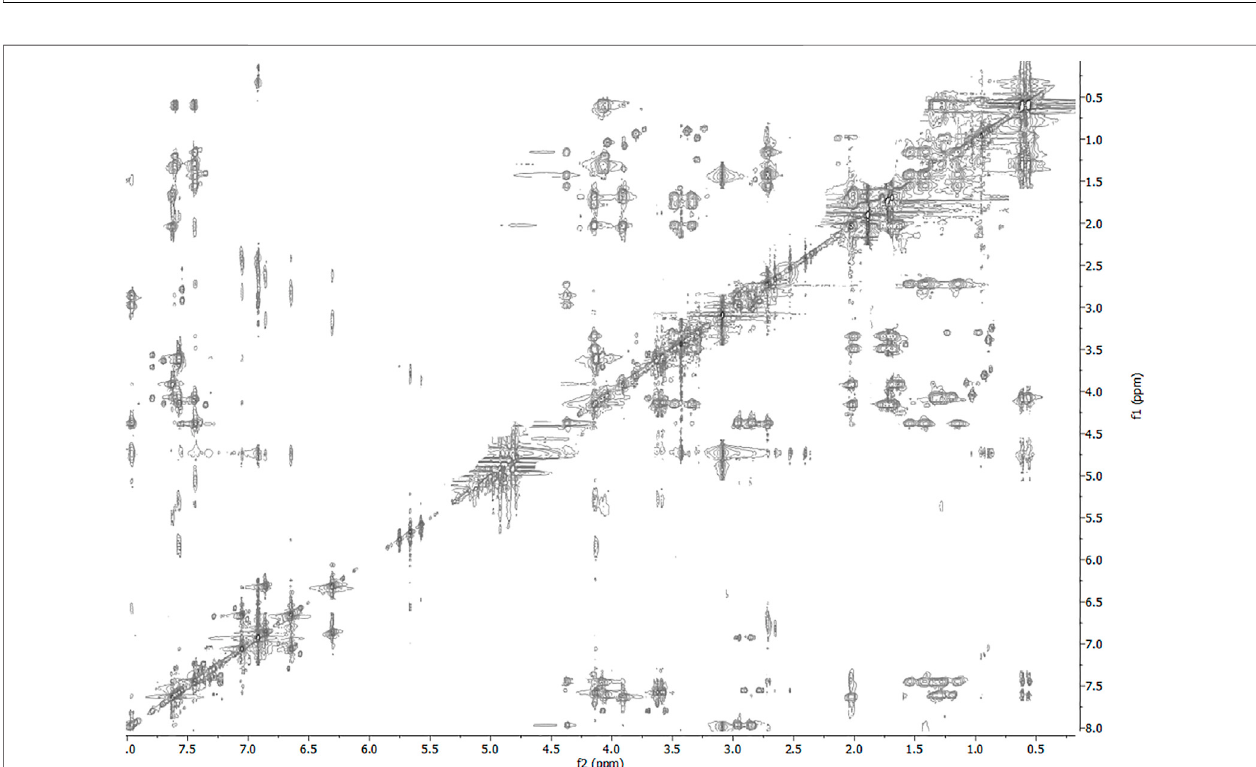
FIGURE 4 | 2D-TOCSY spectrum of 1 HFA/H 2 O solution (600 MHz, 300 K, t mix (cid:2) 80 ms).